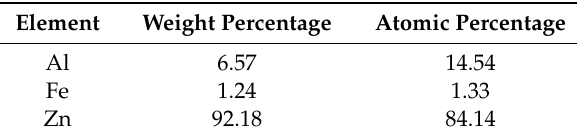
Figure 9. ( a ) No. 4 interface microstructure, ( b ) No. 7 interface microstructure, ( c ) No. 11 interface microstructure, and ( d ) No. 16 interface microstructure. Table 4. Composition of Al–Zn eutectic.